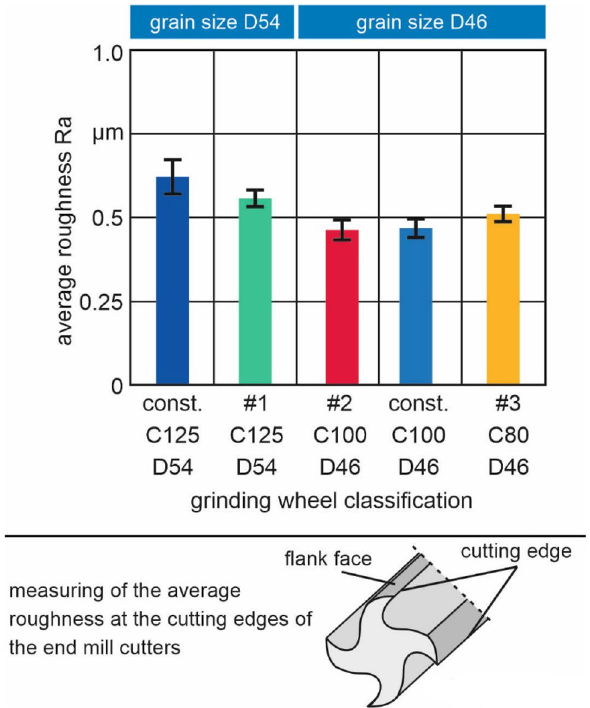
Fig. 10 Average roughness of the end mill cutter cutting edges after grinding for the grinding layer parameters concentration and grain size at the grinding wheel